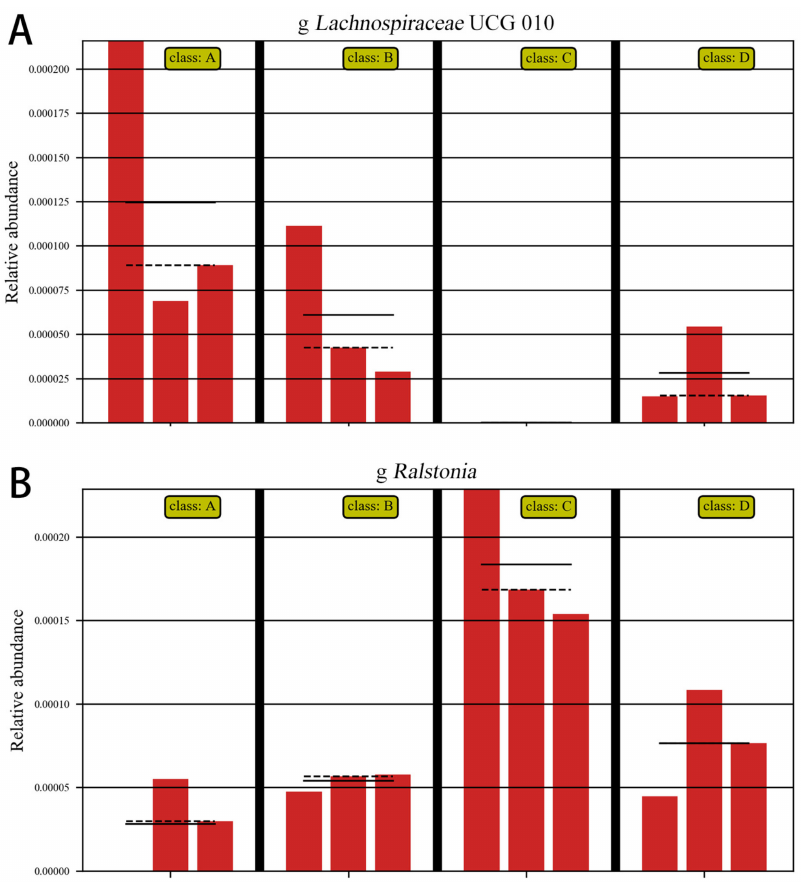
Figure 12. Abundance comparison chart. Note: A: CON group, B: L.S group, C: E. coli group, D: L.S + E. coli group. ( A ): the abundance of Lachnospiraceae ( B ): the abundance of Ralstonia .